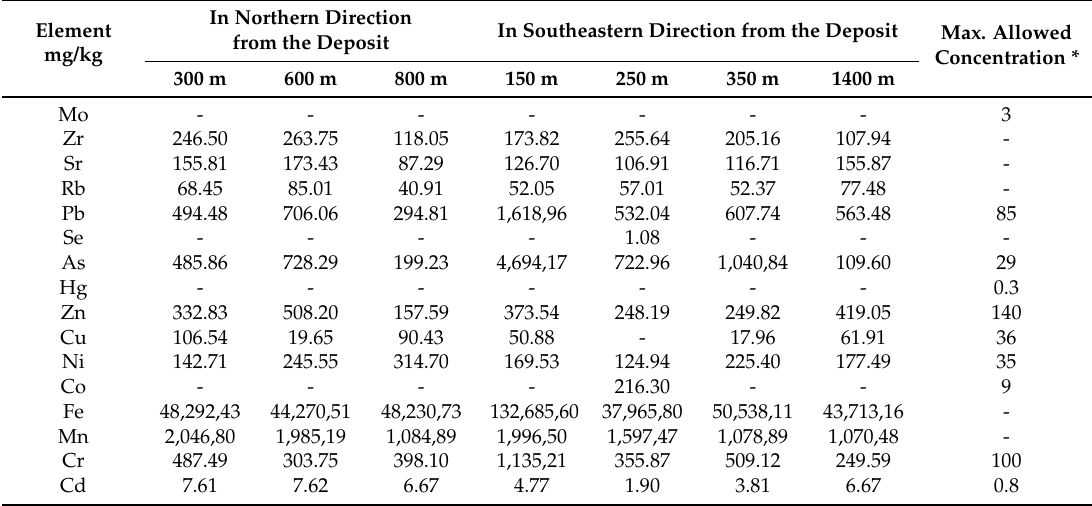
Table 3. Heavy metal concentration in the top soil in the area of Bostanište and their limited values [17]. In Northern Direction Element In Southeastern Direction from the from the Deposit mg/kg